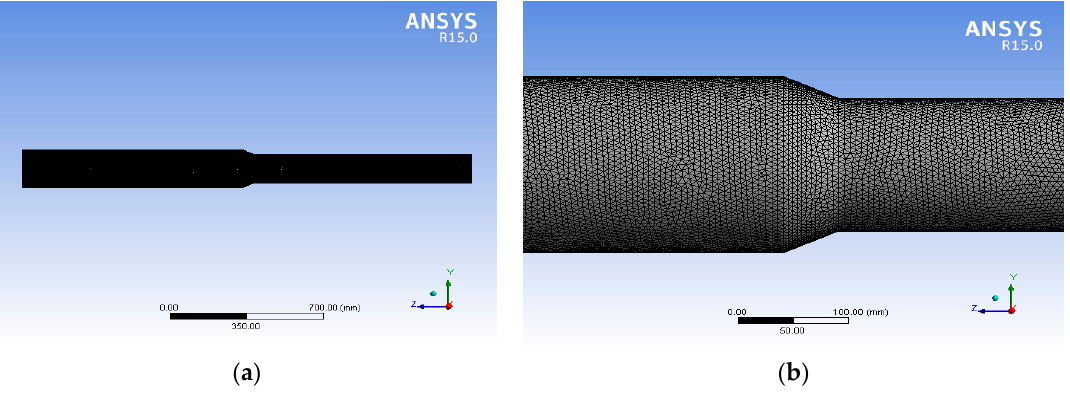
Figure 10. The mashing result. ( a ) Overall view; ( b ) Partial view.